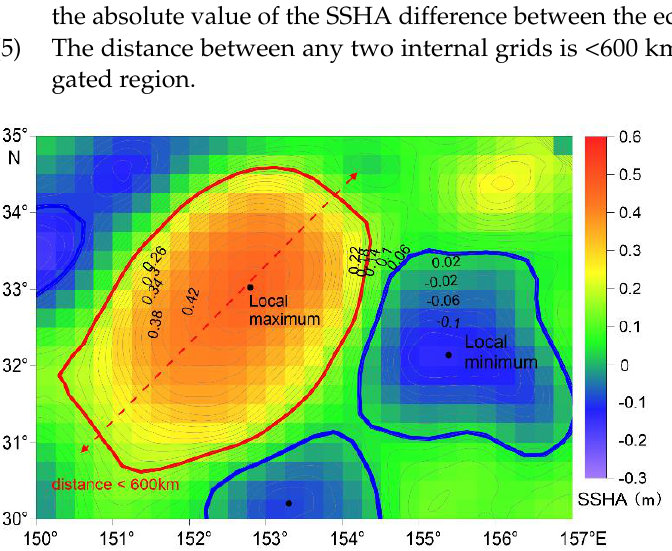
Figure 1. Eddy identification based on gridded SSHA field. Squares with color represent 0.25° grid points of SSHA field, the thin grey lines represent SSHA contours, the thick red and blue lines represent eddy boundaries, and the black points represent eddy centers (local extrema).